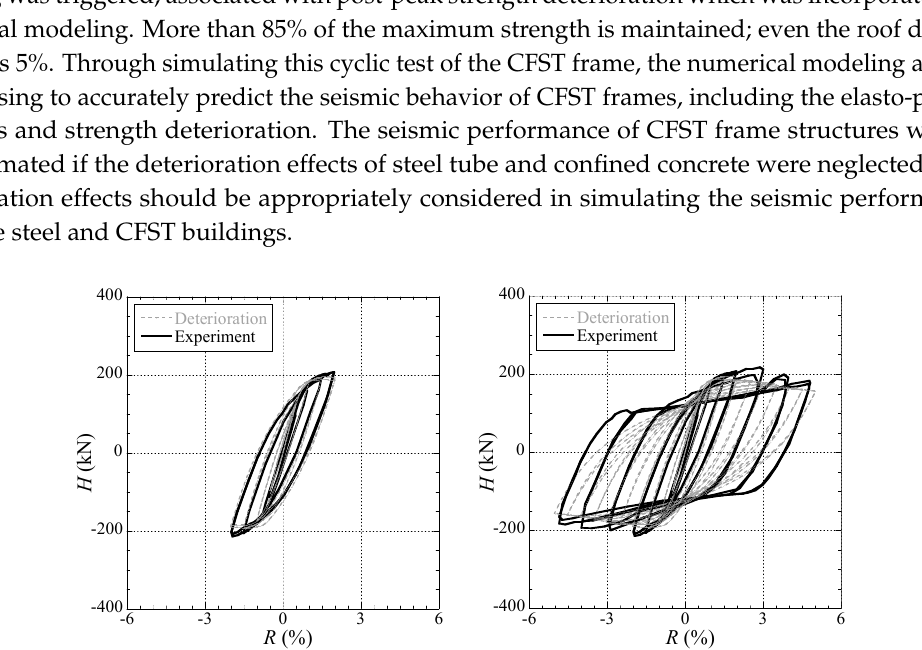
Figure 7. Comparisons between simulation results and experimental results. ( a ) Hysteretic curve when R ≤ 2%; ( b ) Hysteretic curve when R = 5.